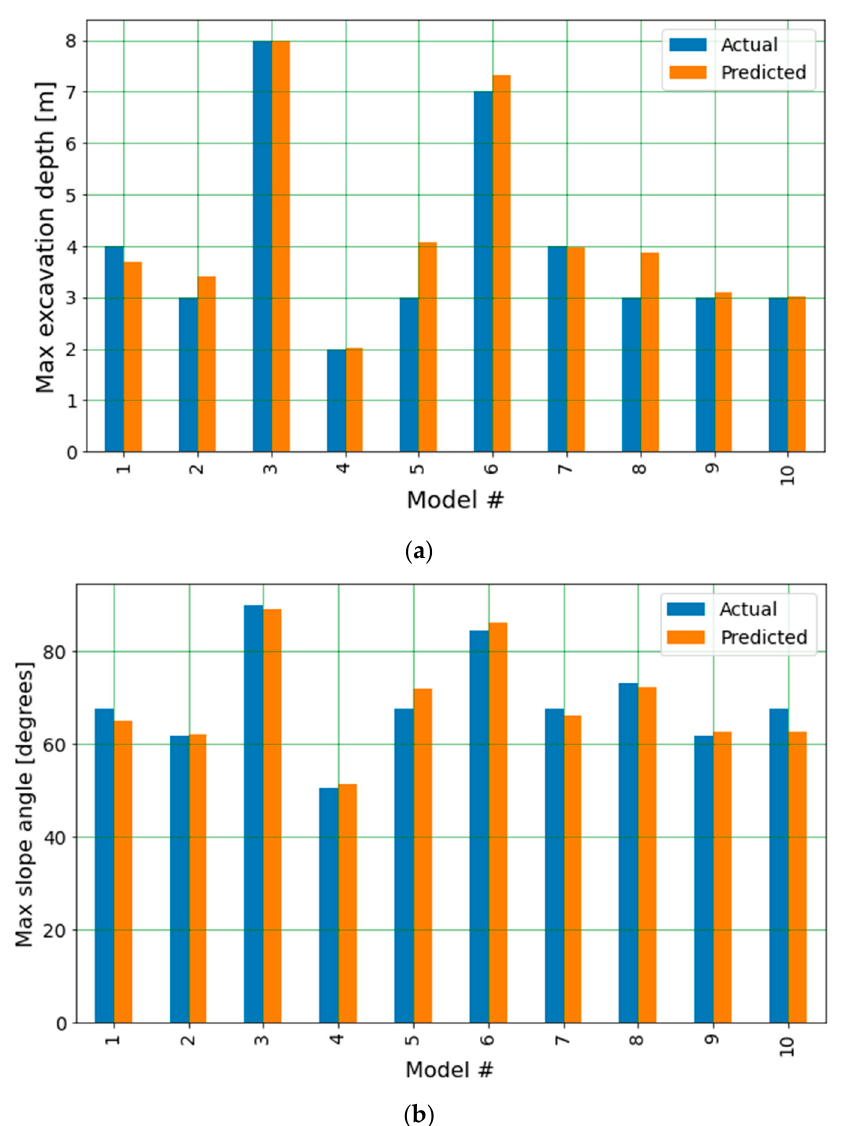
Figure 10. Predicted vs actual results for the RFR models for the ( a ) vertical excavation and ( b ) the slope problem.